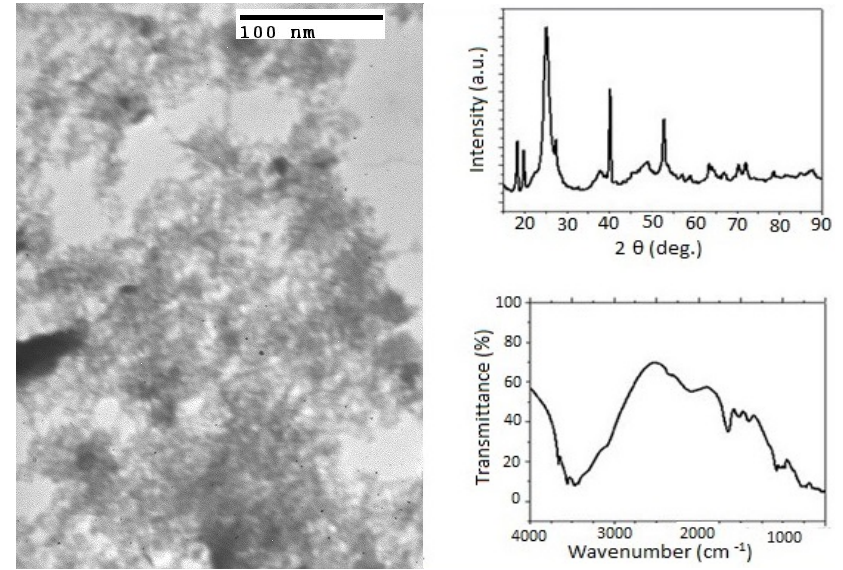
Figure 1. XRD, FTIR, and TEM for the prepared Al 2 O 3 nanoparticles.